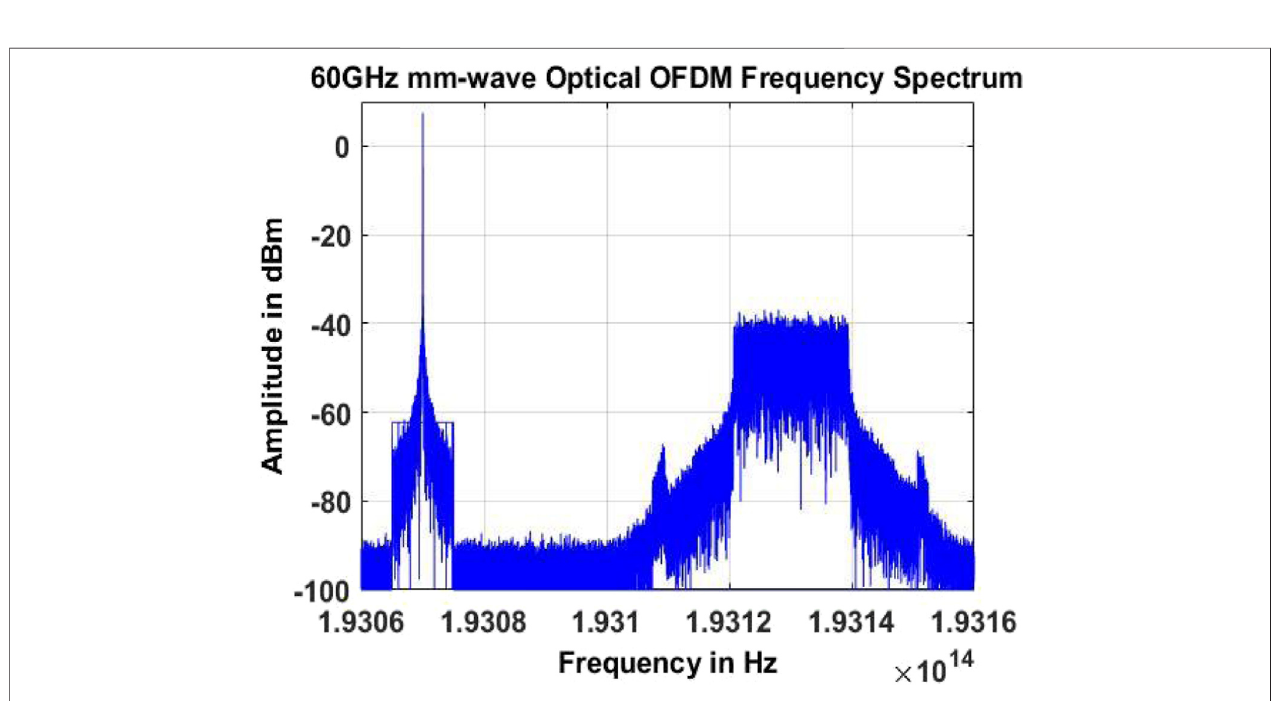
FIGURE 5 | Transmitted 60 GHz optical OFDM frequency